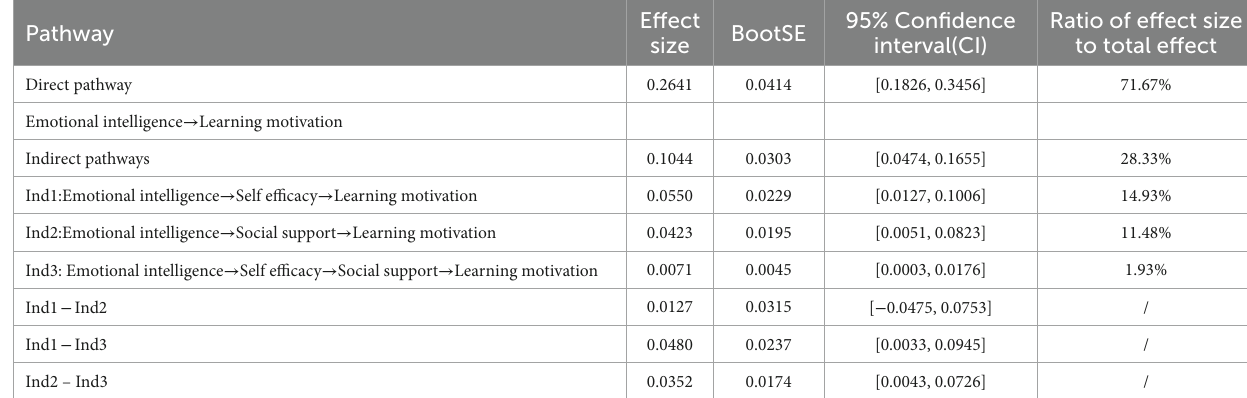
TABLE 8 Analysis of intermediary